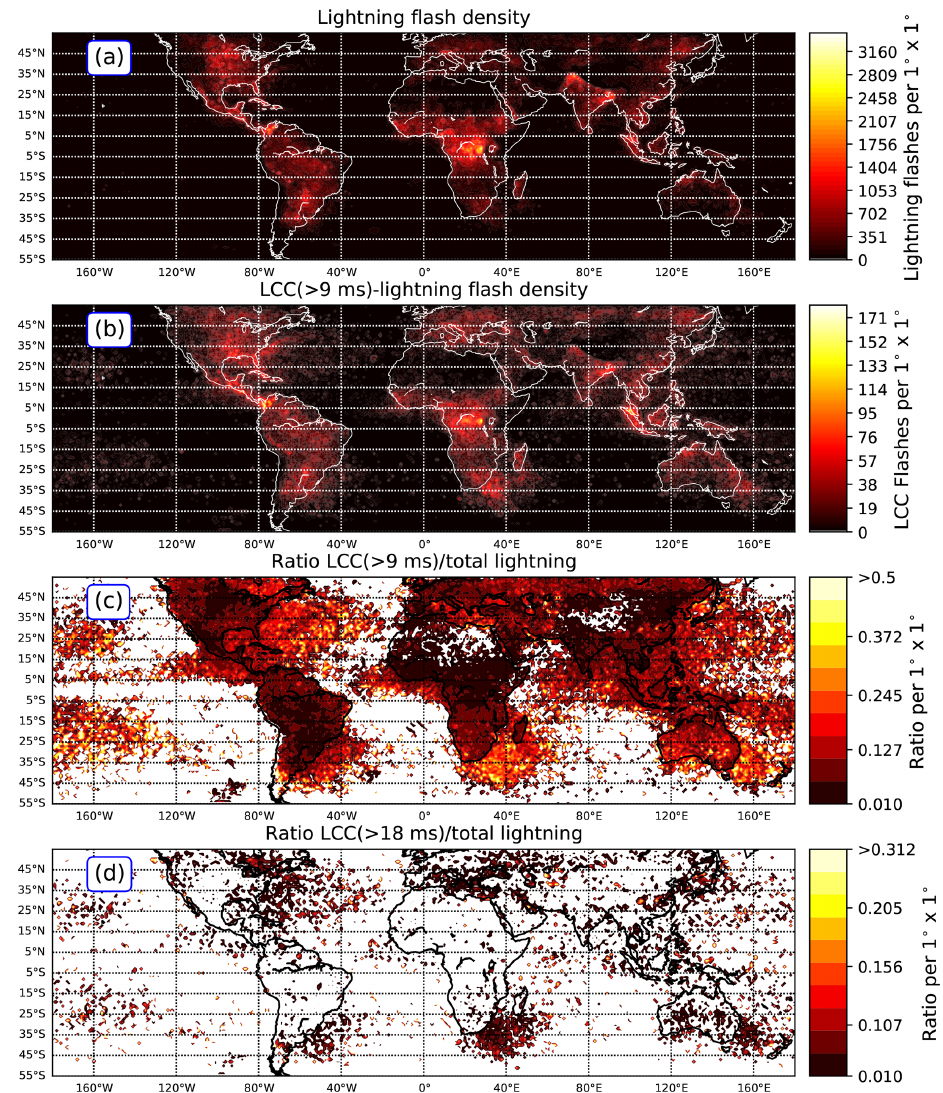
Figure 1. Annual lightning flash density (a) , LCC( > 9ms) lightning flash density (b) , ratio between LCC( > 9ms) lightning and lightning flash densities (c) , and ratio between LCC( > 18ms) lightning and lightning flash densities (d) extracted from ISS LIS data between March 2017 and March 2018 binned into 1 ◦ × 1 ◦ grids. The ratio is undefined in grids without any detection of LCC lightning